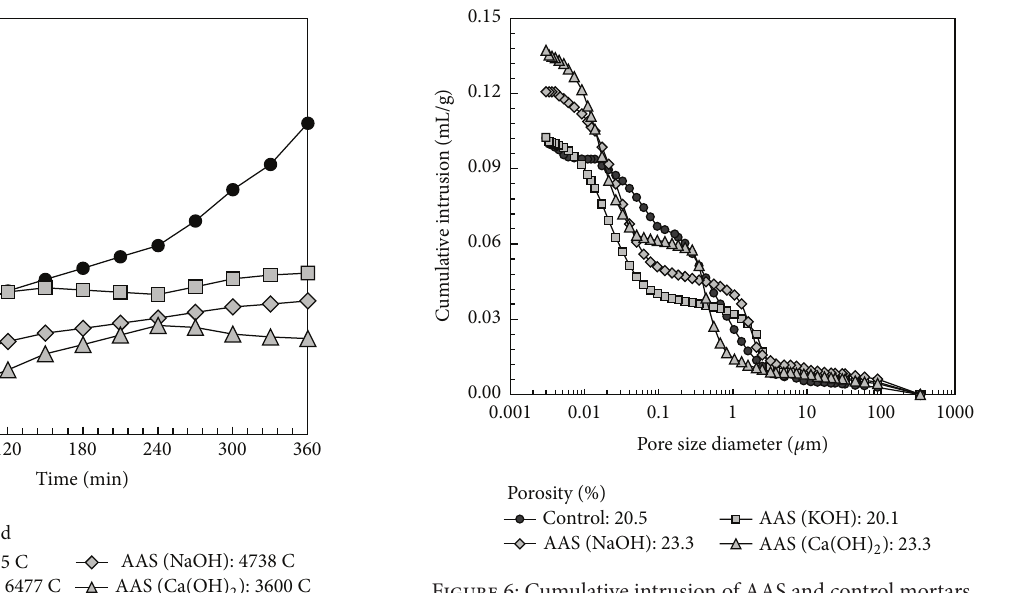
Figure 6: Cumulative intrusion of AAS and control